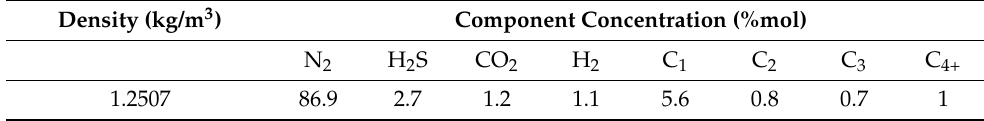
Table 3. Simplified composition of KG natural gas.